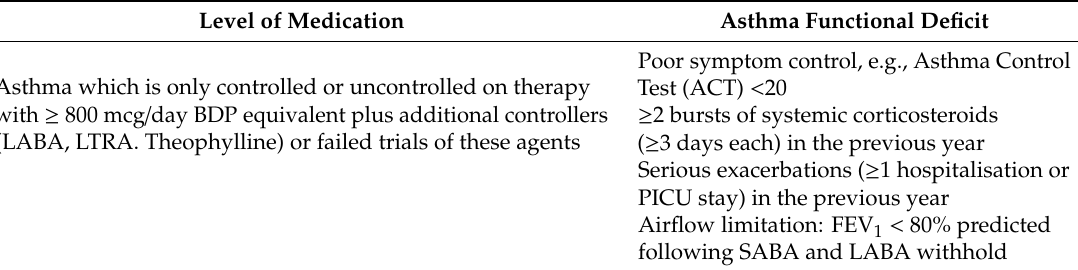
Table 1. ERS / ATS Task Force definition of severe asthma [36]. The level of medication is combined with at least. Level of Medication Asthma Functional Deficit Asthma which is only controlled or uncontrolled on therapy with ≥ 800 mcg / day BDP equivalent plus additional controllers (LABA, LTRA. Theophylline) or failed trials of these